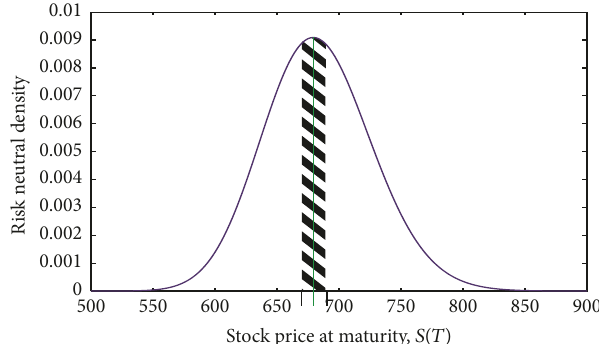
Table 7: Homogeneity belief statistics in